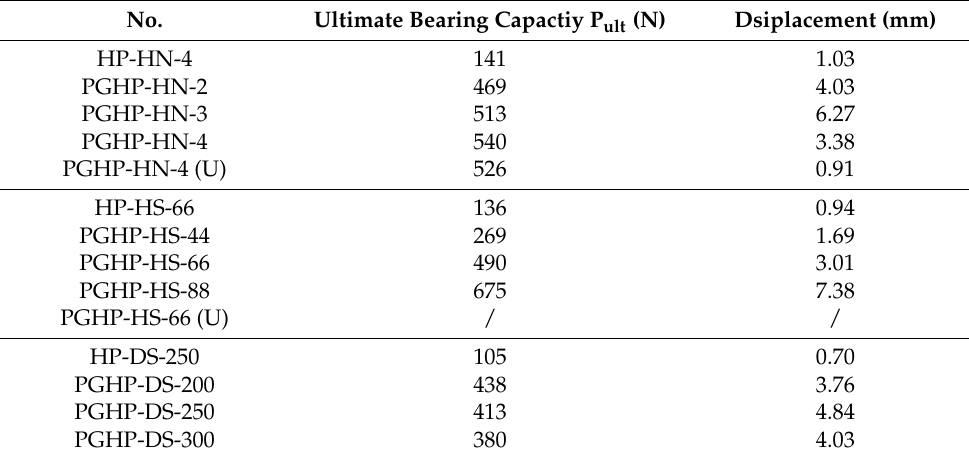
Table 4. Ultimate bearing capacity estimated from the load–settlement